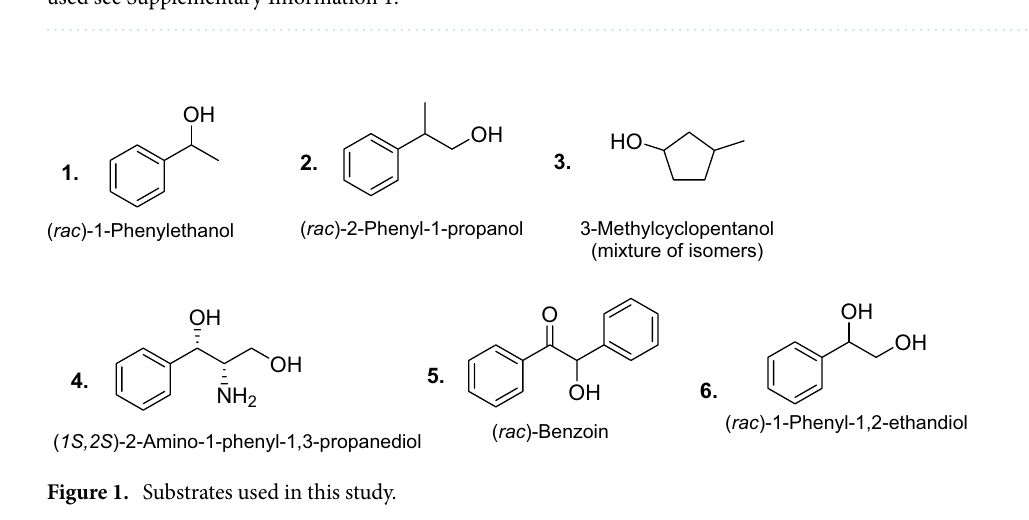
Table 1. Summary of the characteristics of the 3 enzyme classes used in this study. a For additional mediators used see Supplementary Information 1.